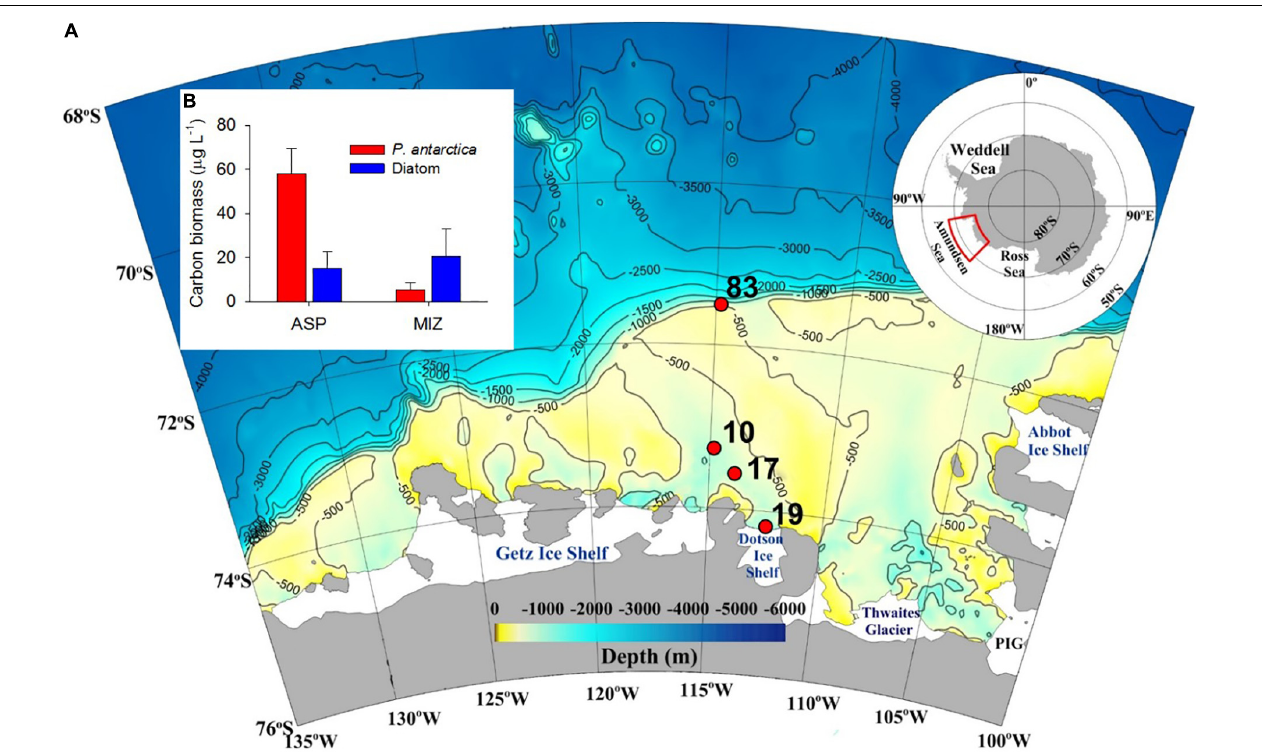
FIGURE 1 | A map showing the sampling sites (A) , and the average carbon biomass ( µ g L − 1 ) of the major phytoplankton groups (B) at Amundsen Sea sites during the austral summer 2012. ASP and MIZ denote Amundsen Sea polynya and marginal ice zone (MIZ),